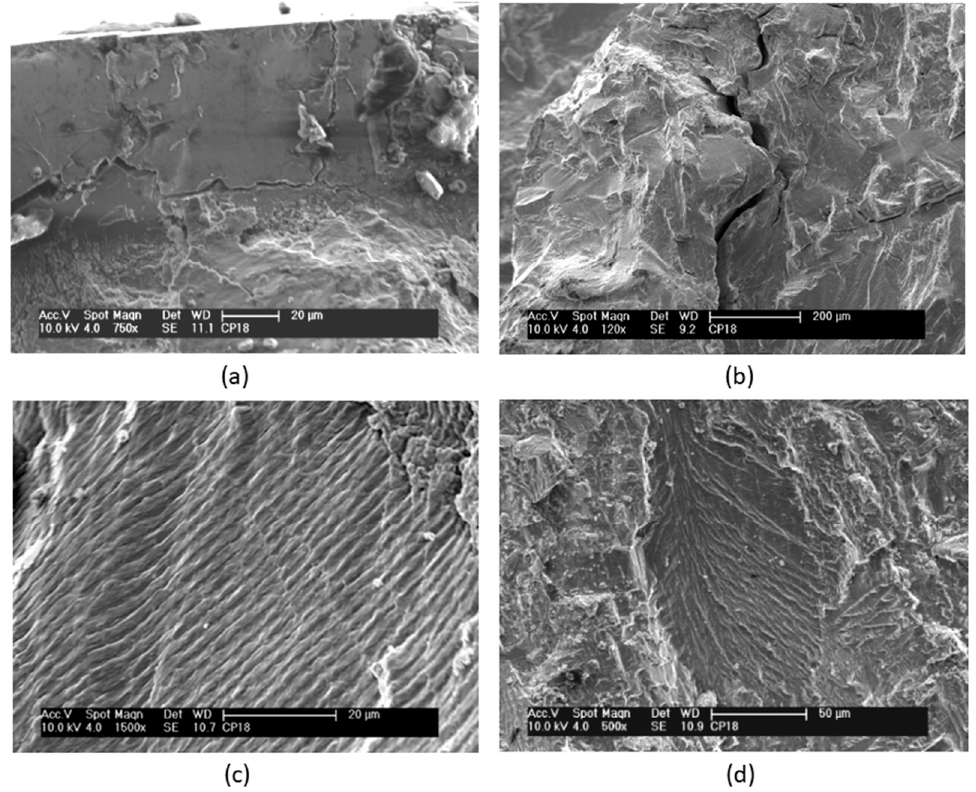
Figure 6. Scanning electron micrographs of the fracture surfaces of nitrided specimens after fatigue tests at 304 MPa and 233,000 cycles to failure. ( a ) A planar region where the crack originated. ( b ) Microcracks perpendicular to the propagation direction. ( c ) Striations. ( d ) Lamellar microstructure consisting of α and β phases.